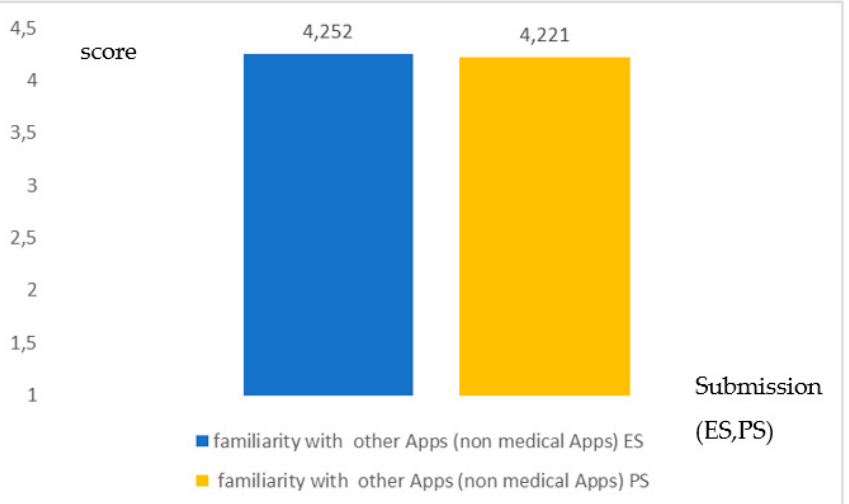
Figure 4. Coherence in the degree of familiarity with other Apps (non-medical Apps) both for the ES and the PS. ( p = 0.301). The graphic indicates a high coherence between the two groups.